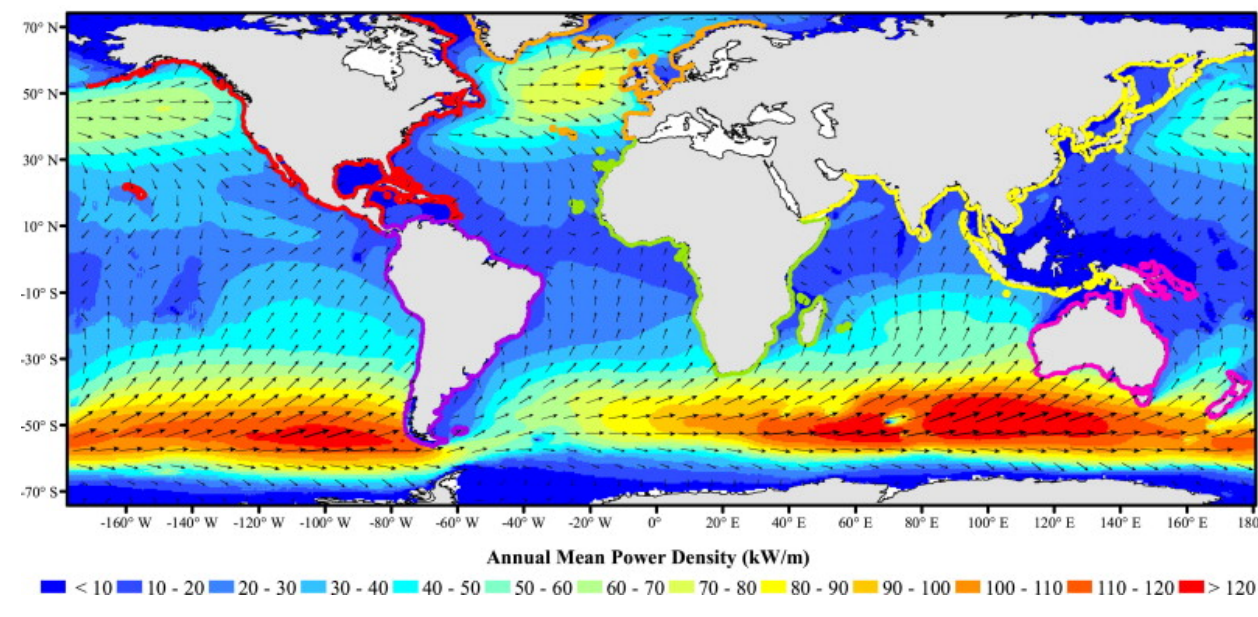
Figure 3. Annual average power per meter of wave crest (adopted from [43] with license number 5235061405721). Table 2. Wave energy resources in different coastal areas across different